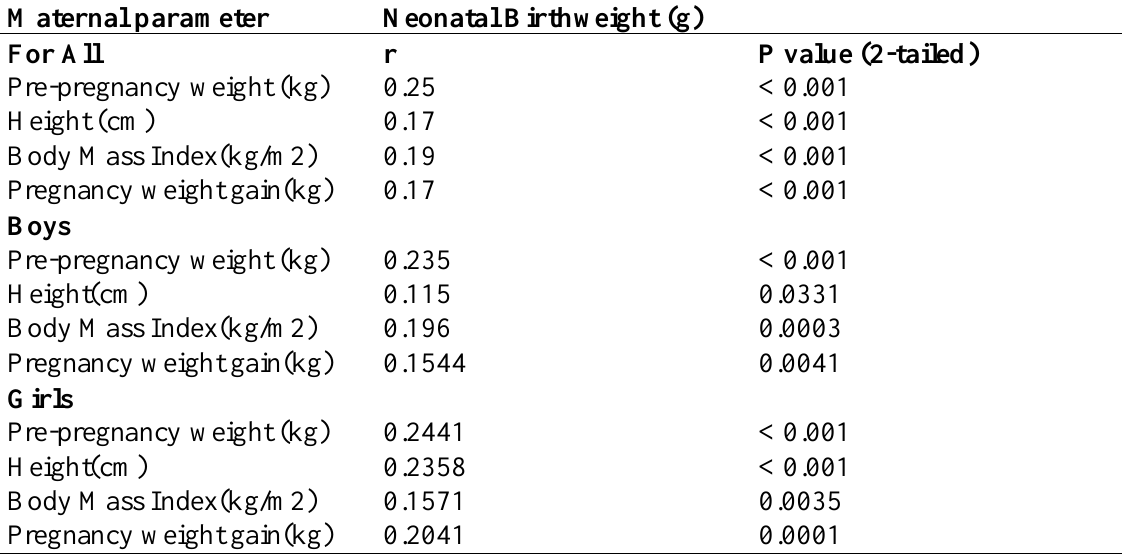
Table 03 - Correlation between maternal anthropometry and neonatal birth weight Maternal parameter